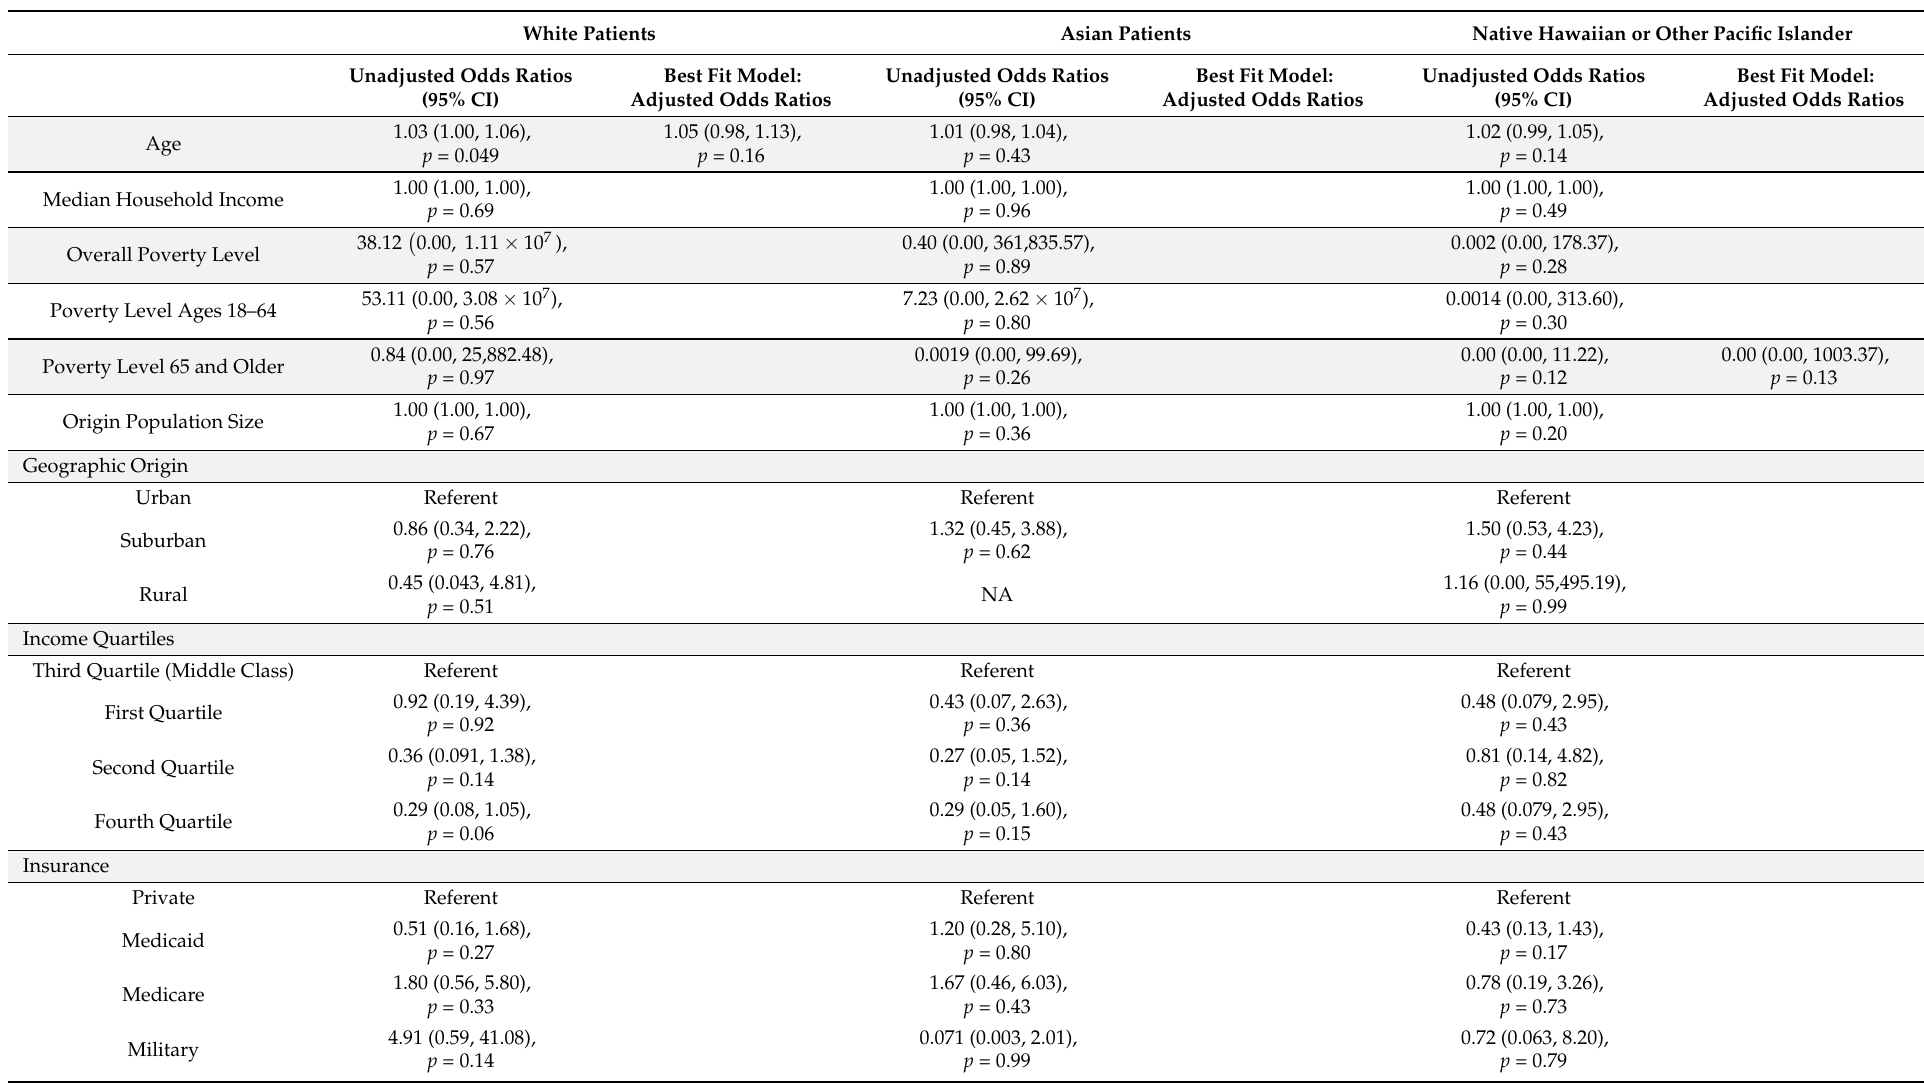
Table 9. Univariate and multivariable analysis of variables associated with vaccine hesitancy for patients with neurological disorders stratified by race. White Patients Asian Patients Native Hawaiian or Other Pacific Islander Unadjusted Odds Ratios Best Fit Model: Unadjusted Odds Ratios Best Fit Model: Unadjusted Odds Ratios Best Fit Model: (95% CI) Adjusted Odds Ratios (95% CI) Adjusted Odds Ratios (95% CI) Adjusted Odds